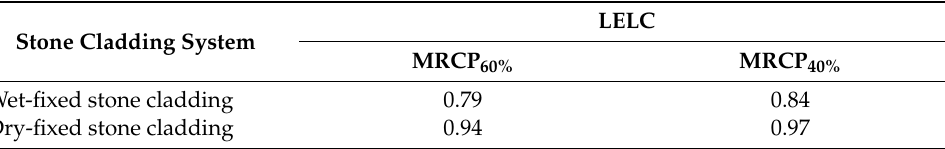
Table 8. Life expectancy limited coefficient, LELC of stone cladding exposed to marine environment, according to Equation